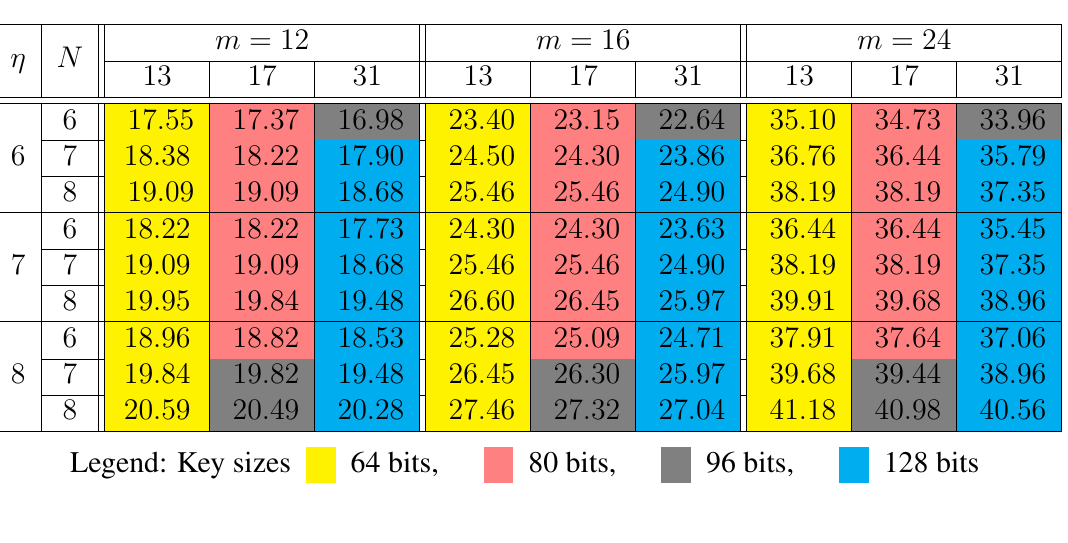
Table 4. Values of log (Φ) . Probable number of master key solutions, Φ